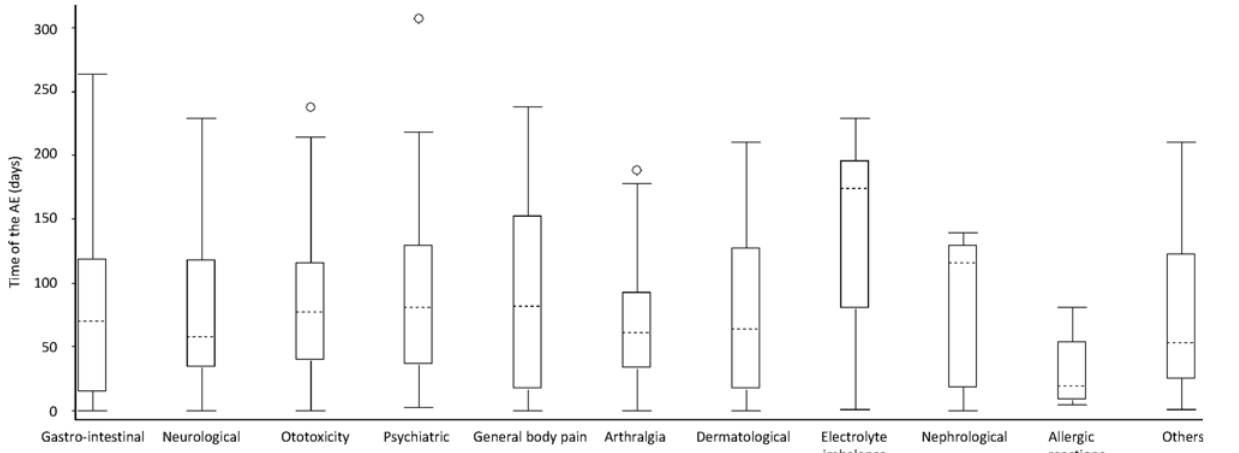
Fig 3. ADRs and time of onset among MDR-TB patients admitted to in-patient care, Nigeria, 2012 – 2013.